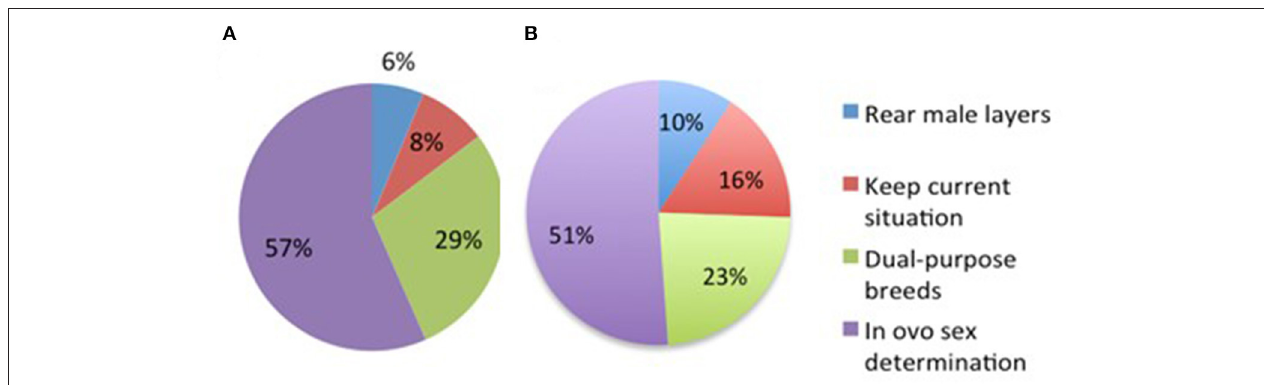
FIGURE 3 | Percentage of respondents’ preference of alternative to culling day-old male chicks (A) Highly educated woman ( n = 143) and (B) Remaining group of respondent ( n = 86).